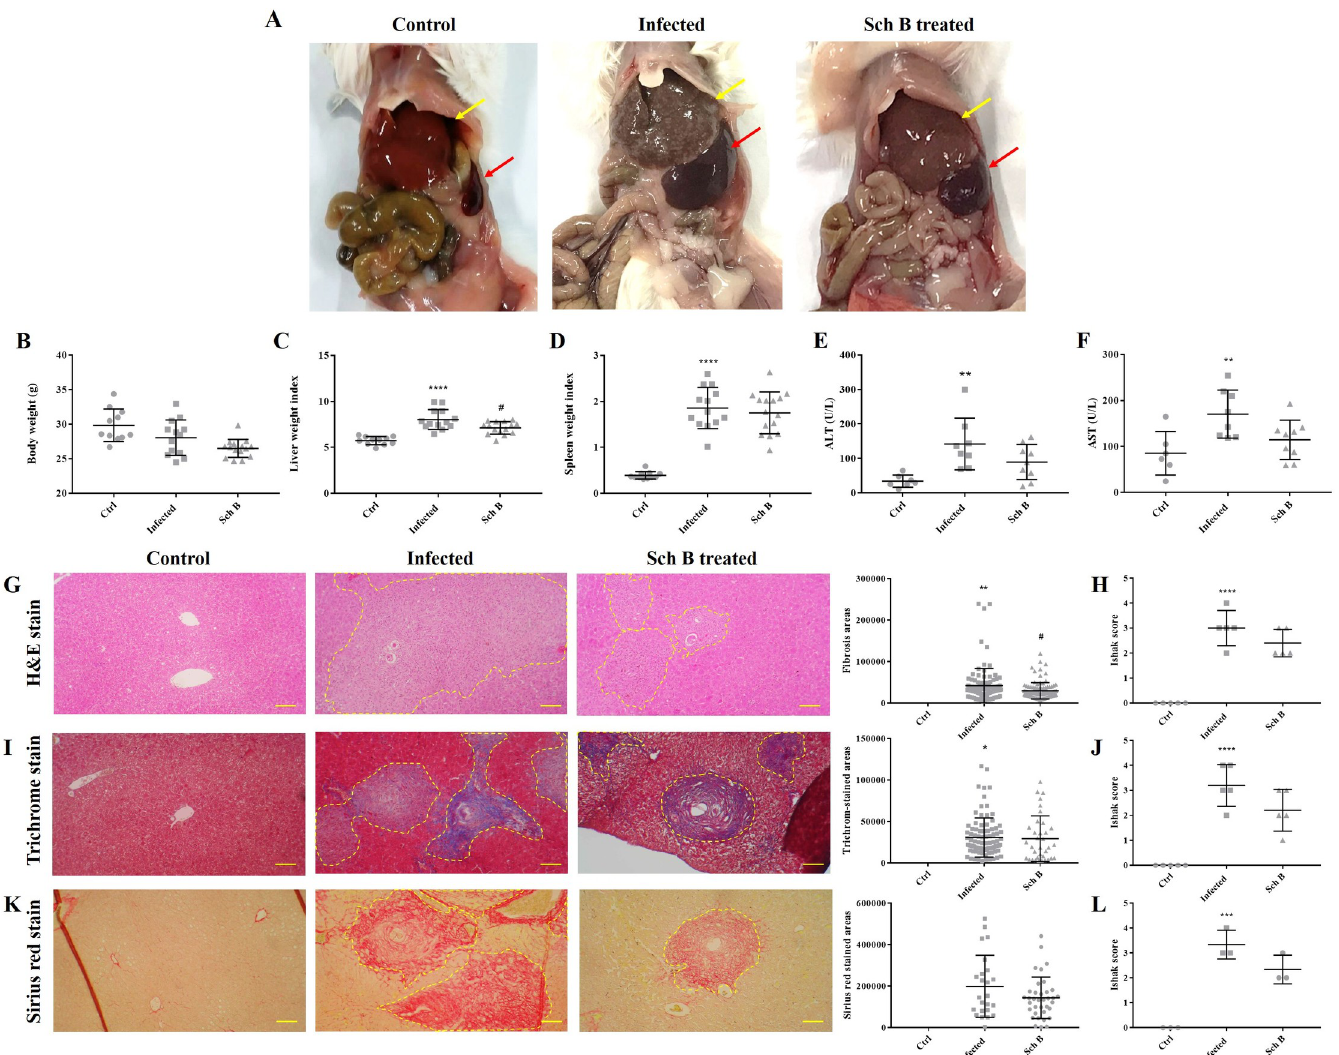
Fig 1. Sch B treatment improves liver function and ameliorates liver fibrosis in S . mansoni -infected mice. (A) Representative images showing gross pathology of control, infected, or Sch B treated mice. Hepatosplenomegaly was observed in infected mice (liver, yellow arrows; spleen, red arrows). White spots seen on the surface of liver indicate granuloma nodules. Effect of Sch B on (B) body weight changes, (C) liver weight index (calculated by liver weight relative to body weight), and (D) spleen weight index (calculated by spleen weight relative to body weight). All results are shown as mean ± S.D. (n = 11–15). (E) ALT and (F) AST levels measured in the serum. Hemolyzed samples were excluded. All results are shown as mean ± S.D. (n = 6–9). (G) Representative images showing H&E staining of liver sections of the mice. Fibrotic areas were encircled by a yellow dotted line. (H) Fibrosis was evaluated by Ishak fibrosis scoring based on H&E staining. (I) Representative images of Masson’s trichrome staining on liver sections of the mice. Collagen were stained as blue which was encircled by a yellow dotted line. (J) Ishak fibrosis scoring based on Masson’s trichrome staining. (K) Representative images of Sirius red staining on liver sections of the mice. Collagen were stained as red and were encircled by a yellow dotted line. (L) Ishak fibrosis scoring based on Sirius red staining. For quantification in (G, I, and K), the number and the corresponding areas of each circled area were potted directly on the graph. Each dot represents one fibrotic or positively stained area. Quantification or scoring was performed on five (H&E staining and Masson’s trichrome staining) or three (Sirius red staining) slides in each group. 15 random microscopic fields were examined on each slide. Images are shown at 100 × magnifications and scale bars correspond to 200 μ m. � P -value < 0.05, �� P -value < 0.01, ��� P -value < 0.001, and ���� P -value < 0.0001 compared with control group; # P -value < 0.05 compared with infected